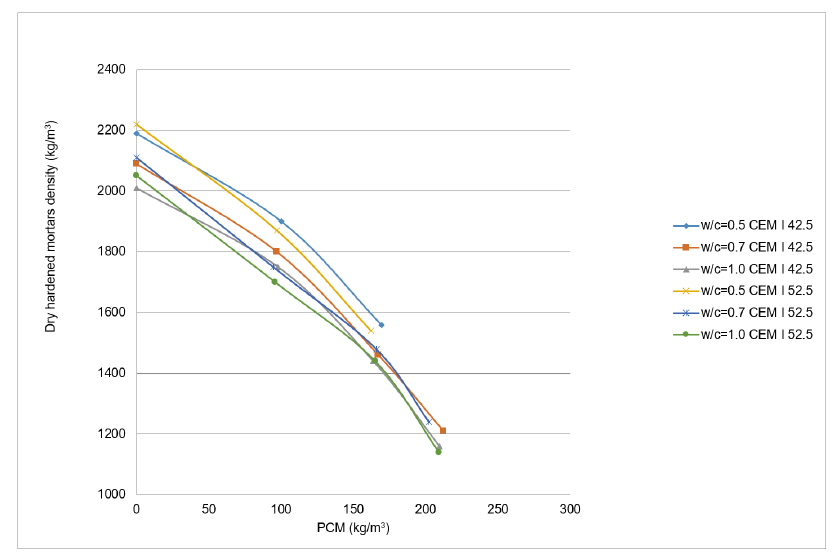
Figure 11. Dry hardened PX27 mortars density variation.